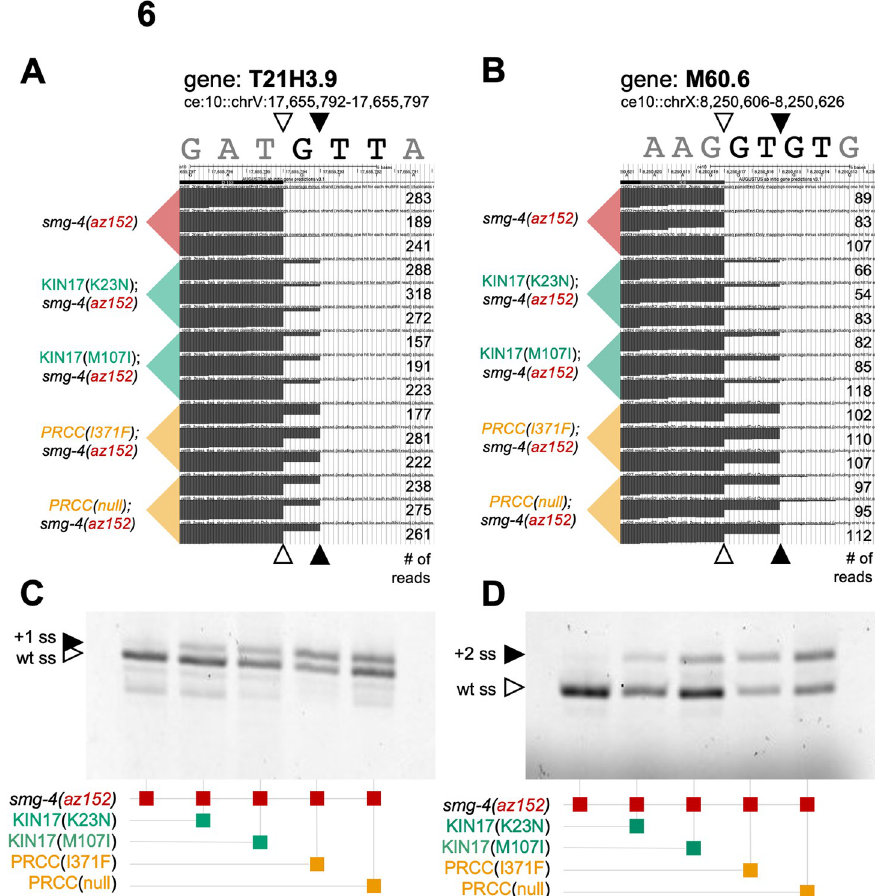
Fig 6. KIN17(K23N) and KIN17(M107I) affect 5’ splice site in a similar manner to PRCC mutations, but with a smaller effect size. (A) UCSC Genome Browser shot of RNA-seq coverage tracks at the gene T21H3.9. For each of five strains indicated on the left-hand side, three replicates are visible for each, the number of reads supporting the track is on the right-hand side. White triangles indicate the wildtype splice site reduced in mutant; black triangles indicate the alternative splice site promoted in mutant. The 5’ splice site switching in KIN17 is above wildtype levels but did not meet our strict criteria for inclusion in Table 1. (B) UCSC Genome Browser shot of RNA-seq coverage tracks at the gene M60.6. For each of five strains indicated on the left-hand side, three replicates are visible for each, the number of reads supporting the track is on the right-hand side. White triangles indicate the wildtype splice site reduced in mutant; black triangles indicate the alternative splice site promoted in mutant. The 5’ splice site switching in KIN17 is above wildtype levels but did not meet our strict criteria for inclusion in Table 1. (C) Verification of RNA-seq results showing that KIN17 mutations switch 5’ ss, just not as strongly as PRCC mutations. Image is a scan of a denaturing poly-acrylamide gel showing Cy-3 labeled T21H3.9 PCR products from mixed-stage cDNA. (D) Verification of RNA- seq results showing that KIN17 mutations switch 5’ ss, just not as strongly as PRCC mutations. Image is a scan of a denaturing poly-acrylamide gel showing Cy-3 labeled M60.6 PCR products from mixed-stage cDNA. Quantification of three biological replicates of the gels in parts C and D are provided in S5